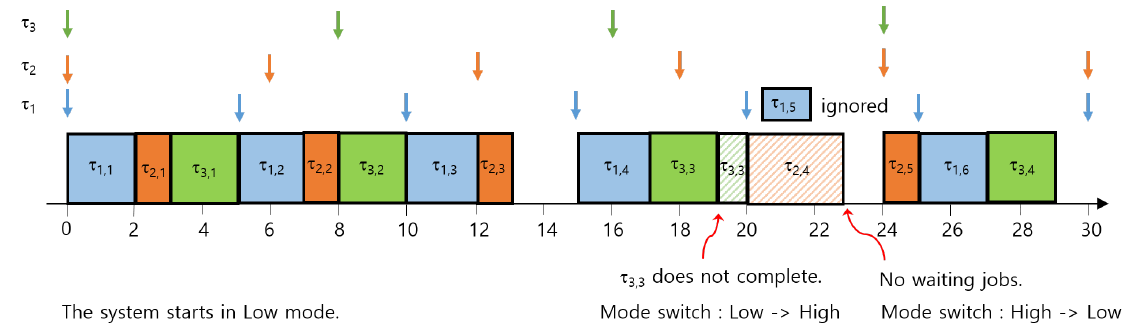
Figure 1. An example of mixed-criticality